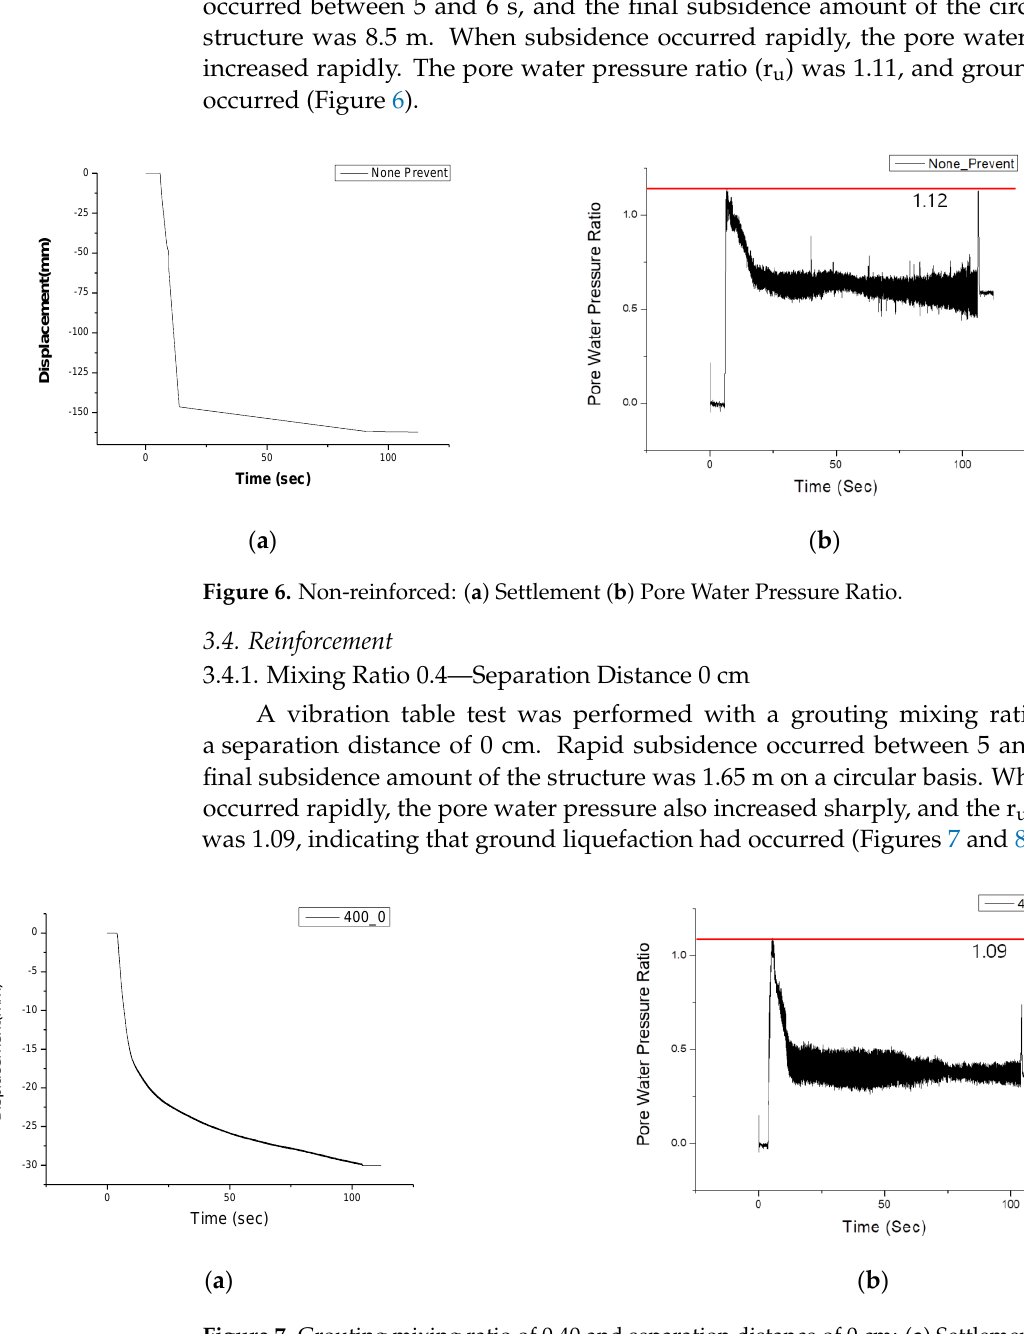
Figure 7. Grouting mixing ratio of 0.40 and separation distance of 0 cm : ( a ) Settlement ( b ) Pore Water Pressure Ratio.